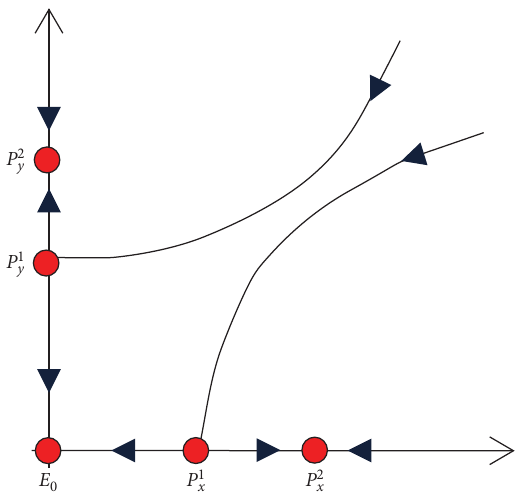
Figure 6: Different manifolds of Theorem